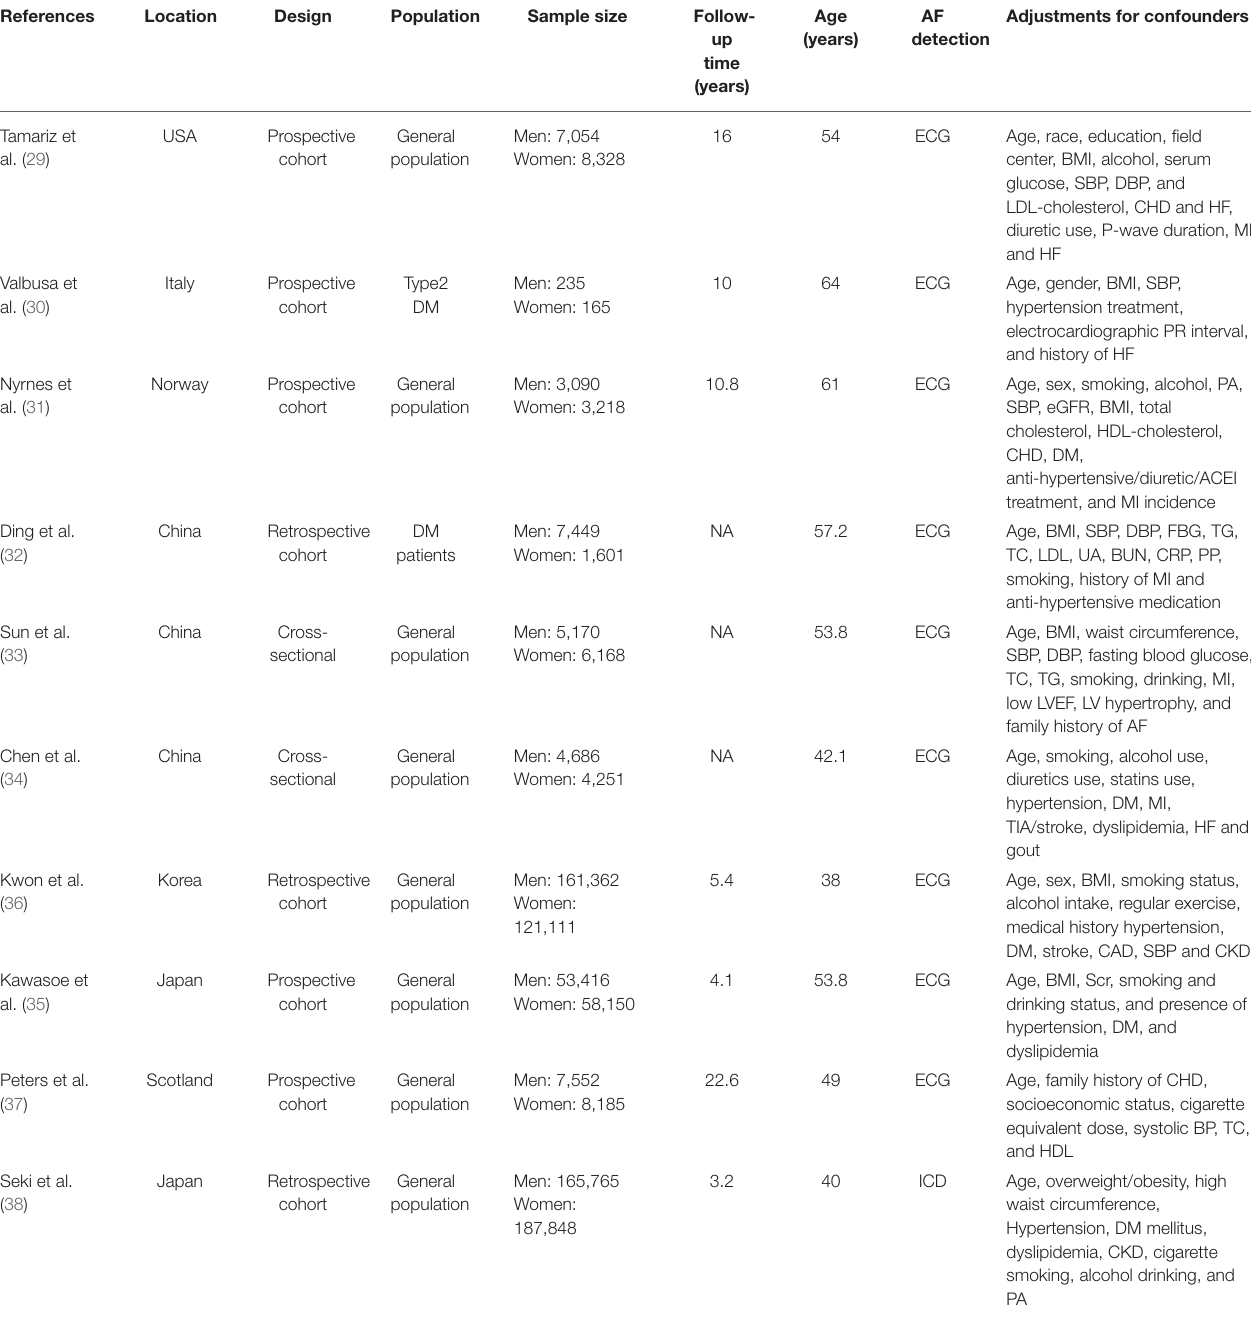
TABLE 1 | Basic characteristics of the articles included in the meta-analysis of serum uric acid and risk of atrial fibrillation in men and